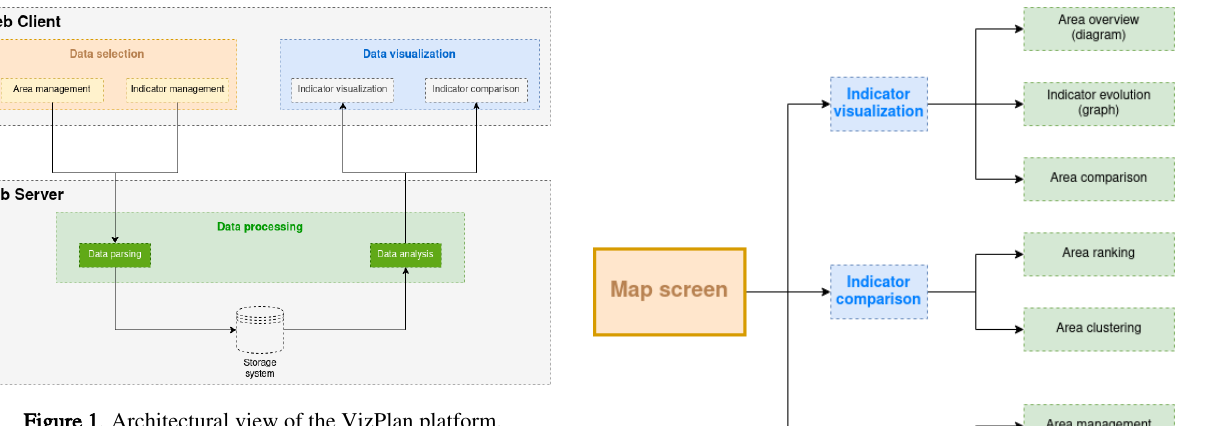
Figure 1. Architectural view of the VizPlan platform.